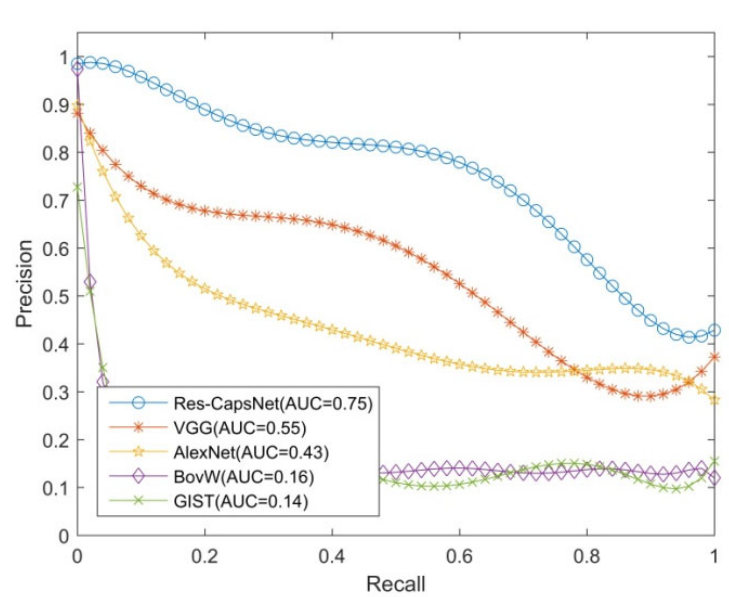
Figure 11. Precision–recall curves of day ‐ left vs. night ‐ right datasets.